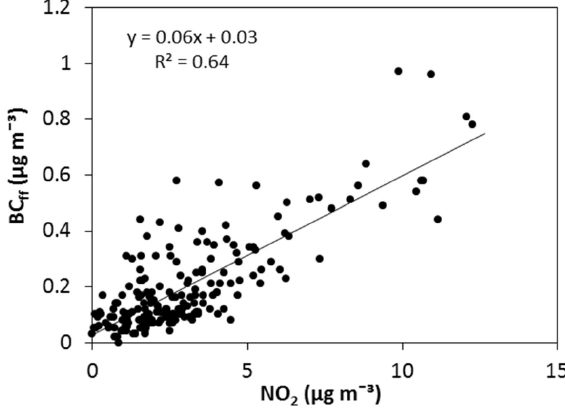
Figure 5. Scatter plot between BC ff and NO 2 for winter season (from November to February,) during the period 2012–2014 at MSY (daily